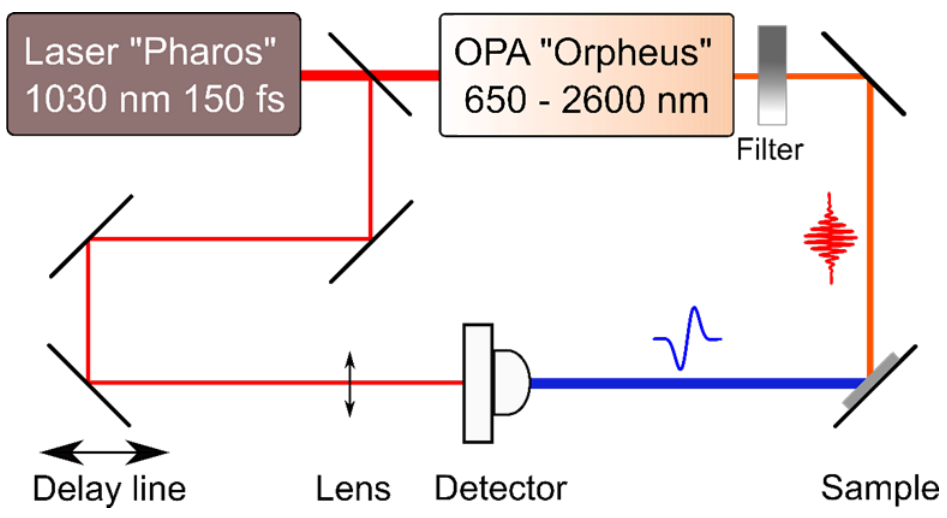
Figure 1. Experimental set-up of THz excitation spectra